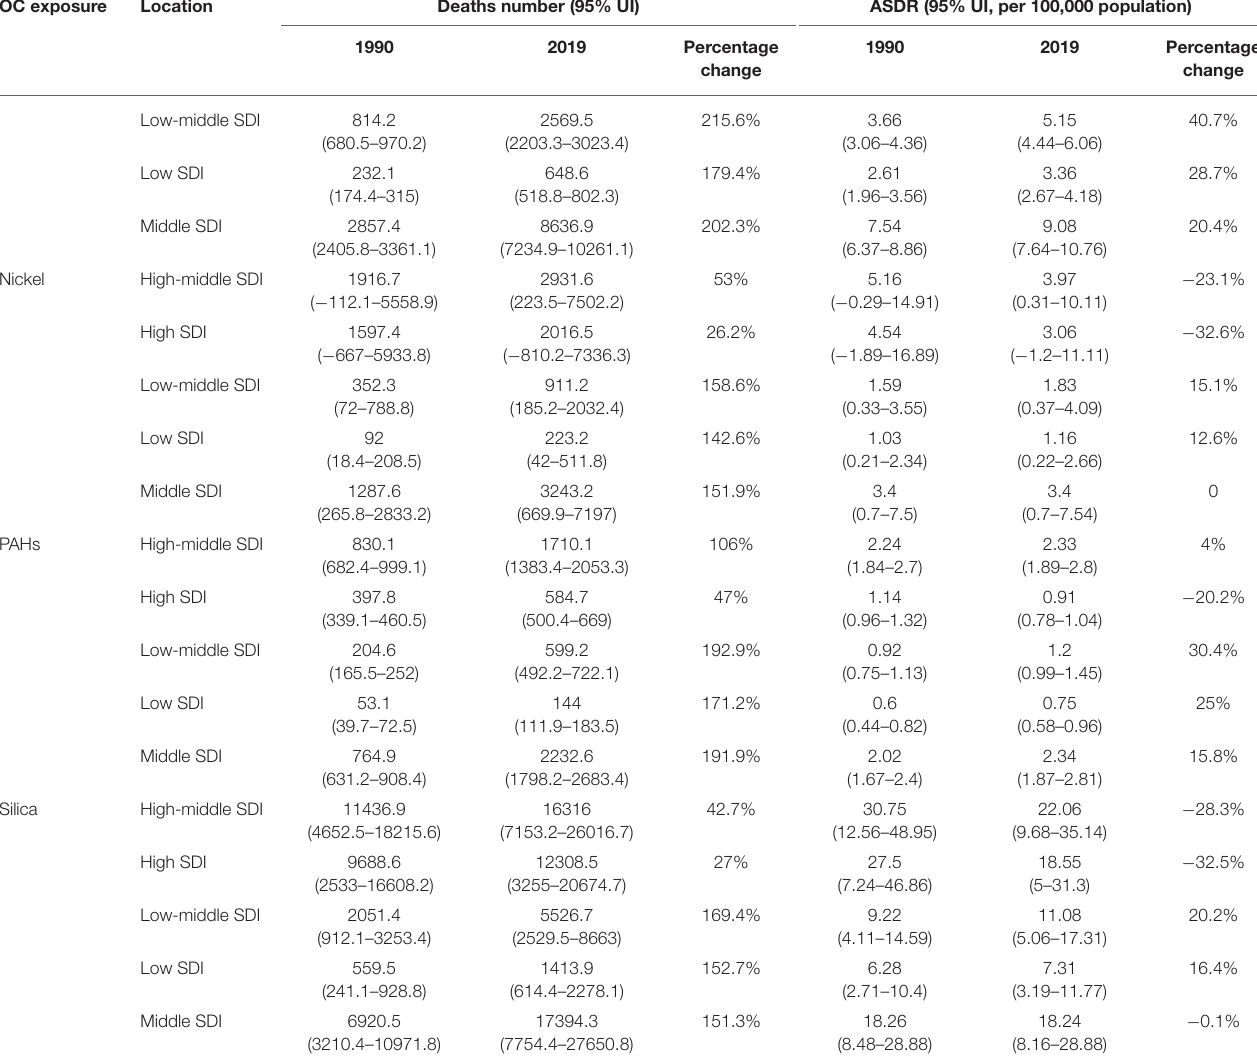
( Figure 2B ). Monaco (323.4 per 100,000) and Greenland (361 per 100,000) were the two countries with the in 2019 ( Figure 2C